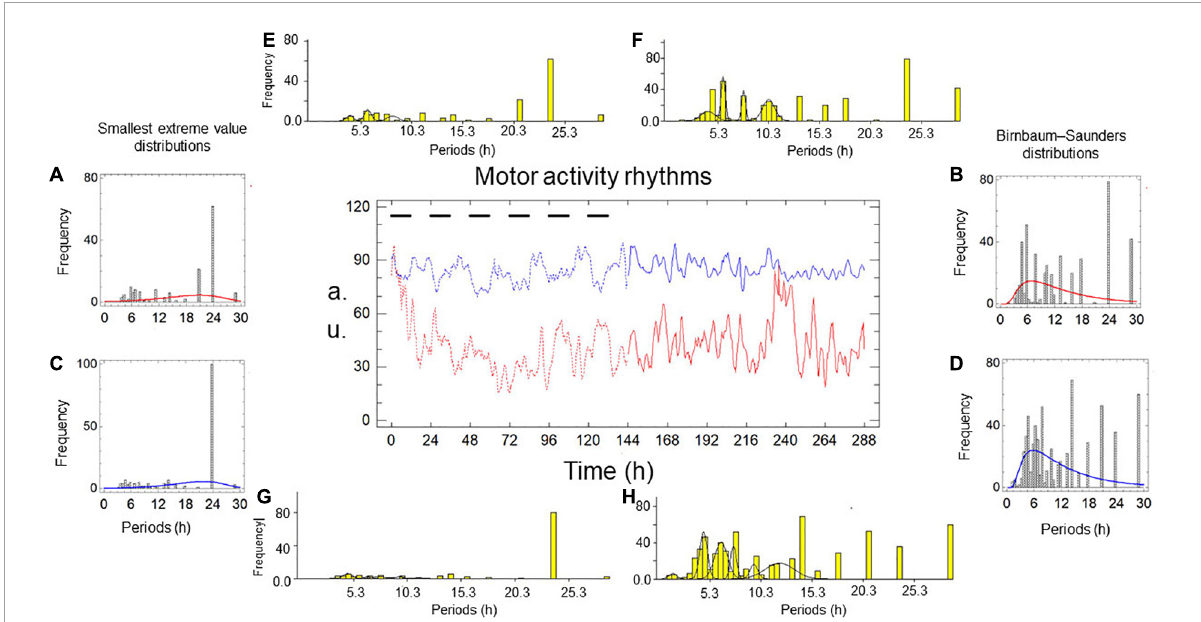
FIGURE2 Motor activity rhythms of the chelipeds of a crayfish under entrainment and during freerunning. In the central graph, the independent variable is time, measured in hours; the dependent variable is the amount of spontaneous activity, measured in arbitrary units (a.u.). The black bars represent the dark phase of the dark-light cycle. The record from the left cheliped (Lc) is the red line, and the record from the right cheliped (Rc) is the blue line. The broken lines represent the entrained rhythms (En) under dark-light cycles (DL, 12:12) for 6 days, and the solid lines represent the freerunning rhythms (Fr) under constant light (LL) for another 6 days. Panels A–D are periodograms and models of the probability distributions. Panels E–H are periodograms and Gaussian components.